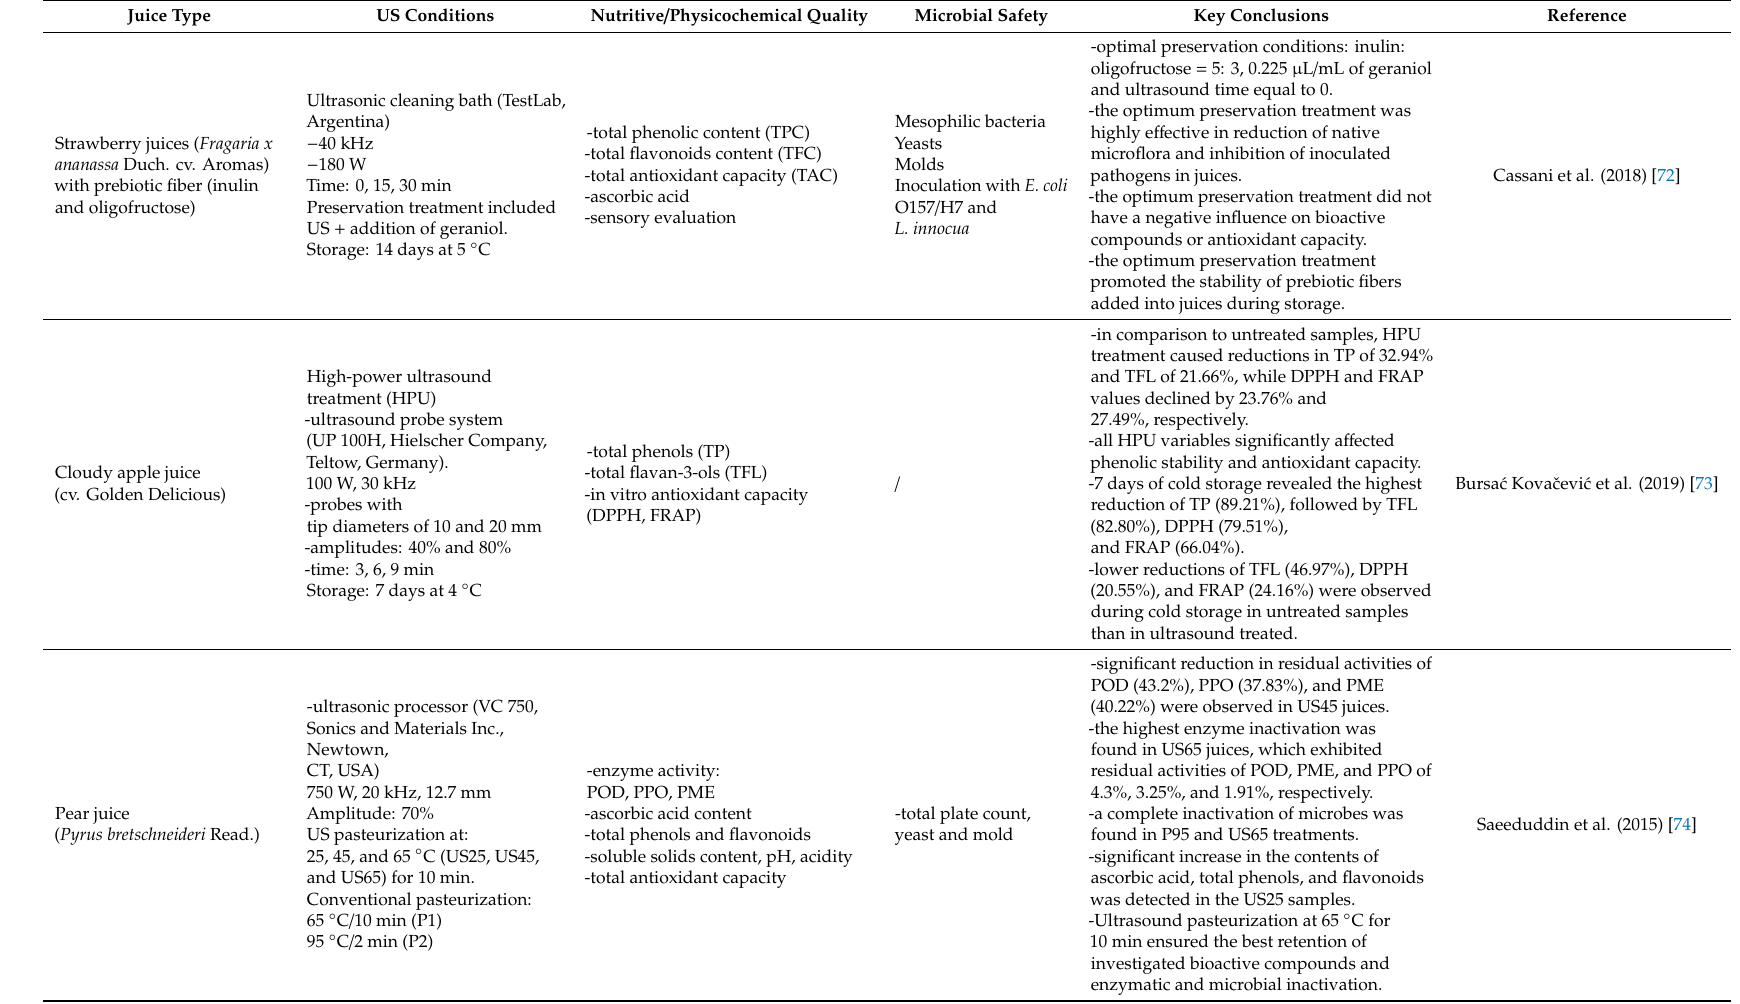
Table 2. The application of ultrasound (US) treatment for the preservation of functional fruit juices and beverages over the last 5